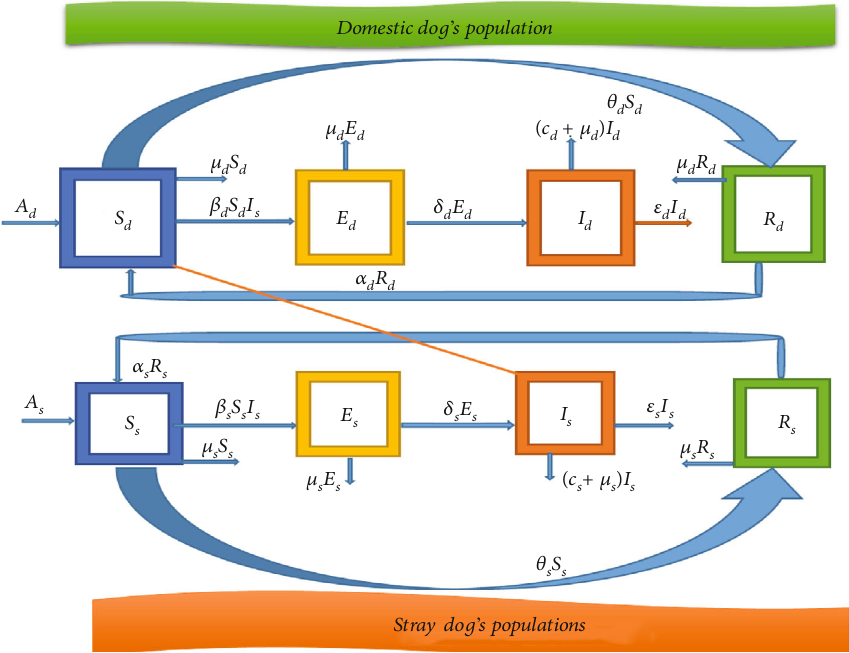
Figure 1: Flowchart illustrating the spread of rabies from stray dogs to domestic